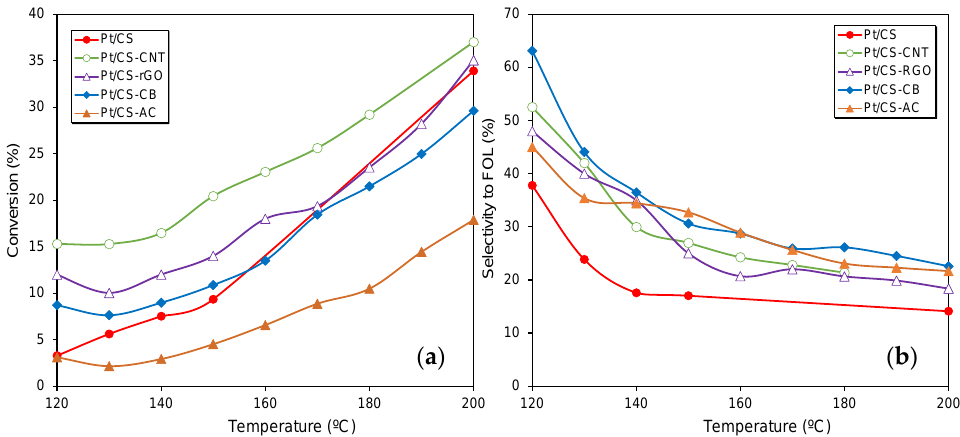
Figure 7. Catalytic performance as a function of reaction temperature over all Pt/carbon catalysts: ( a ) conversion of FUR and ( b ) selectivity to FOL.